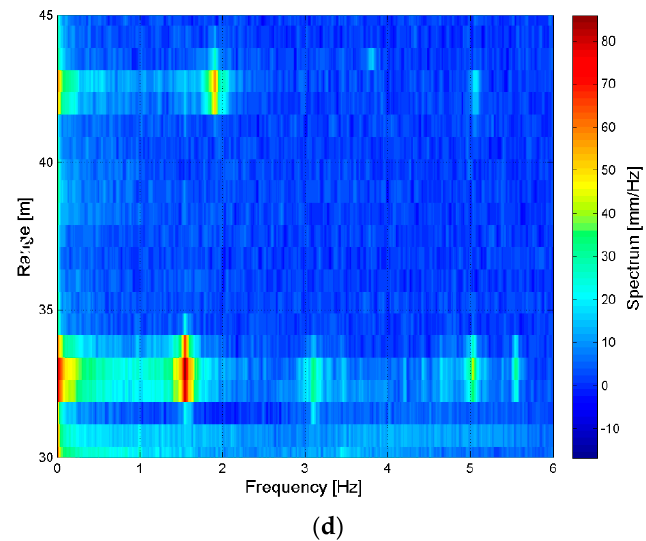
Figure 14. Occhito dam, Carlantino. Monitoring of the pedestrian bridge. Holistic view of ( a ) displacements and ( b ) frequency spectrum of all targets observed by the GBSAR. Frequency peaks can be observed in the range distance intervals [30 m, 35 m] and [40 m, 45 m]. Details of the ( c ) displacement and ( d ) frequency spectrum with the peaks at 1.6 Hz and 2 Hz.